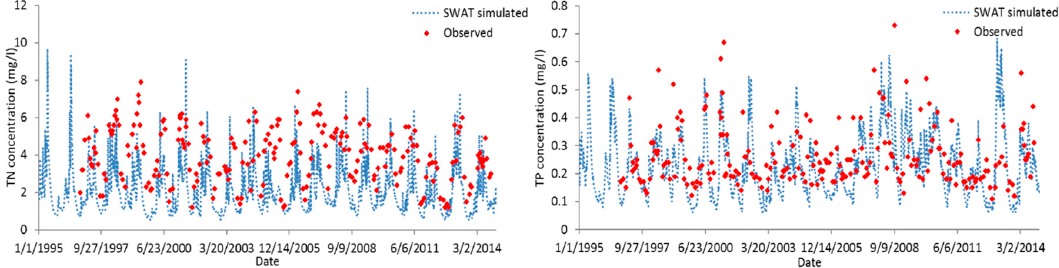
Figure A1. Daily simulated versus observed sediment, TN , and TP concentrations at outlet station Grafton (#05587450) in the UMRB.